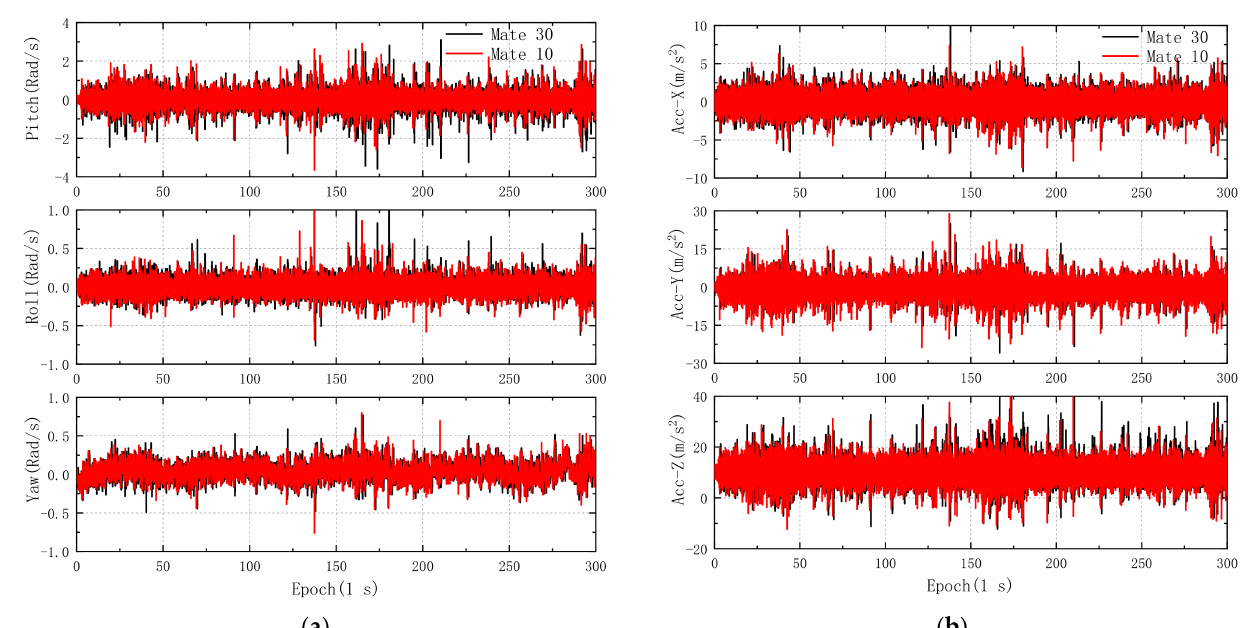
Figure 8. Comparisons of the IMU data from Mate 30 and Mate 10. ( a ) Three-axis gyroscope; ( b ) three-axis